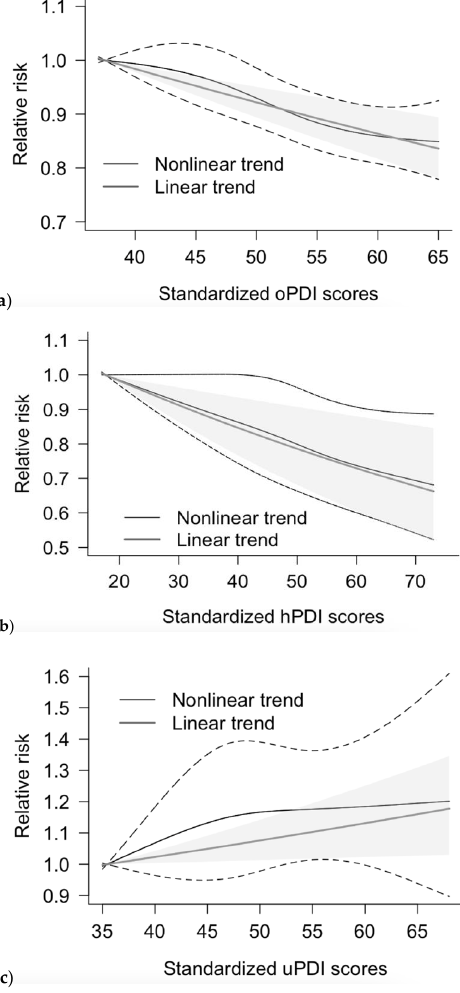
Figure 5. Dose–response analyses for the potential linear and nonlinear associations between plant-based diet indices (PDI) and incident cardiovascular disease (CVD). The shaded areas represent the 95% confidence intervals (CI) for the fitted linear trend (gray solid lines). The dashed line areas represent the 95% confidence intervals (CI) for the fitted nonlinear trend (black solid lines). ( a ). Overall PDI was associated with a lower risk of CVD in a linear fashion (RR: 0.85 (95% CI 0.80 to 0.90) per 25% increase, p for nonlinearity <0.01; p for significance of the curve = 0.53; p for linear association <